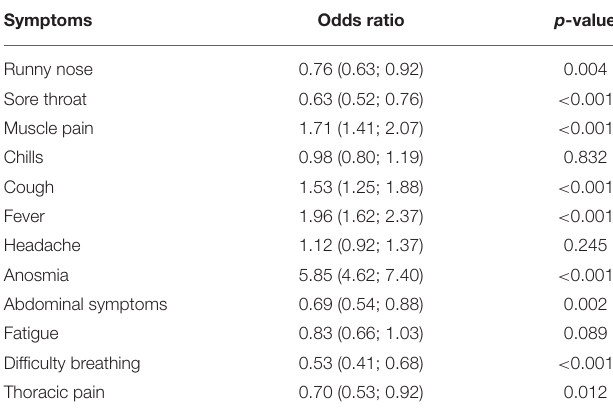
TABLE 3 | Multiple logistic regression with all symptoms predicting the SARS-CoV-2 RT-PCR result ( n = 3,179). Symptoms Odds